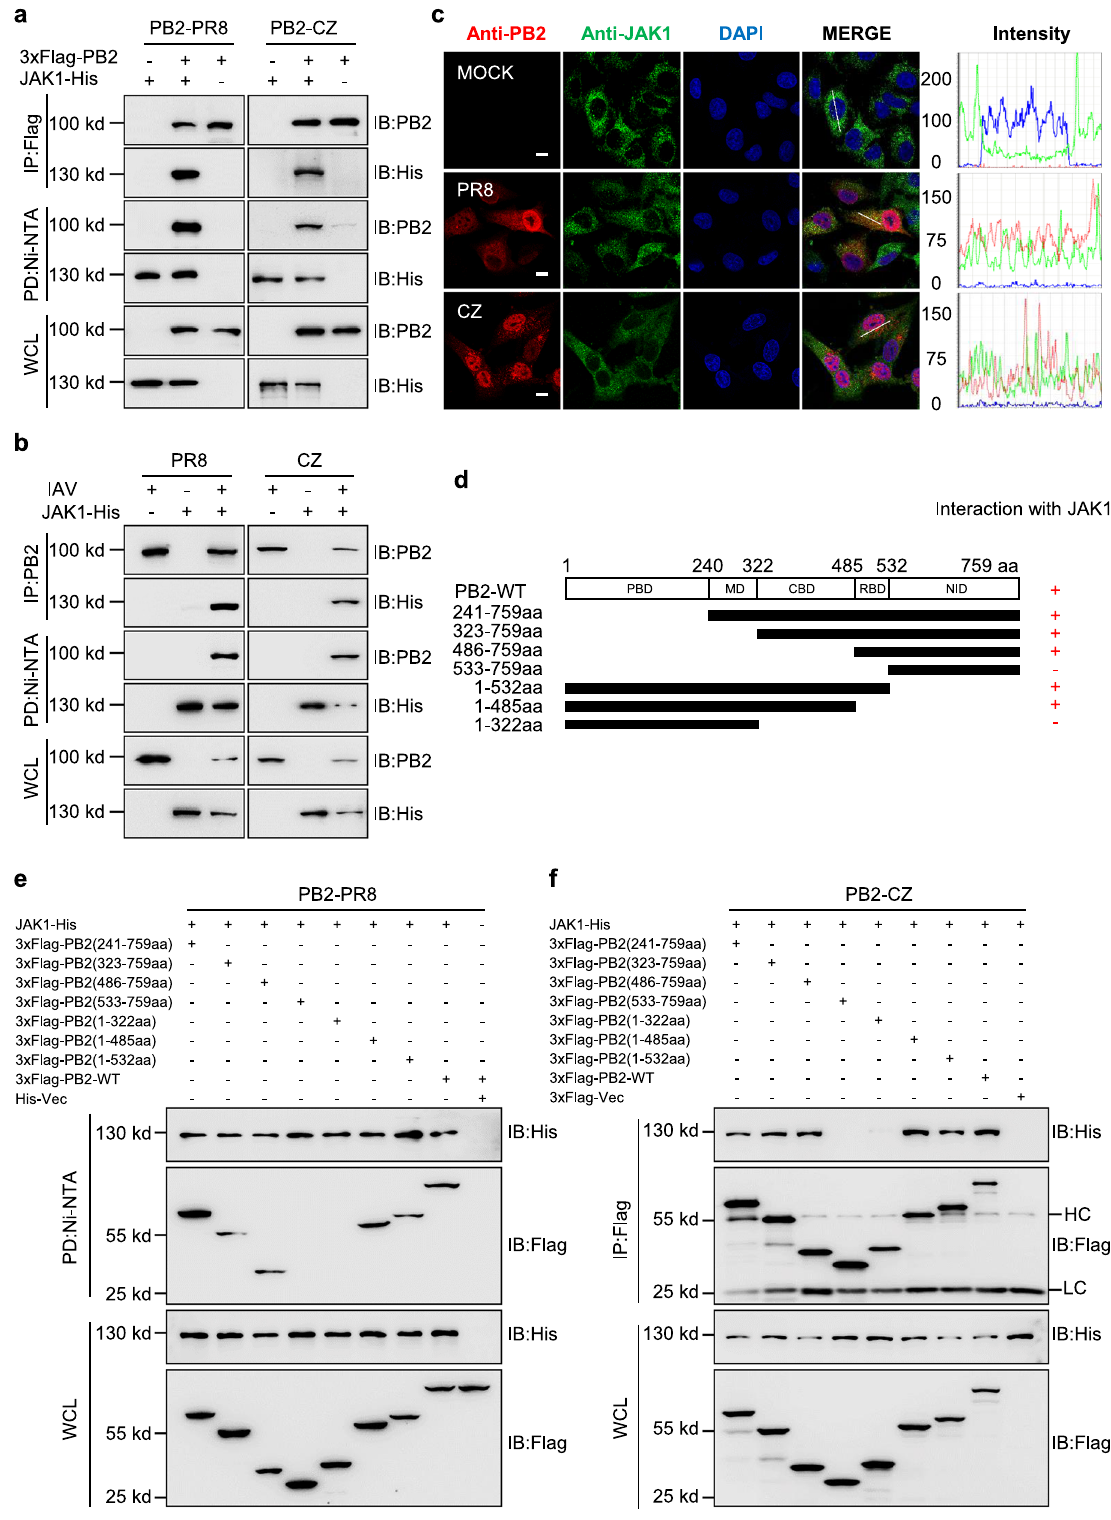
fl uorescence at indicated locations were scanned by LAS X Software. d Schematic representation of the deletion mutants of PB2. e , f Ni-NTA pull-down (e) and Co-ip analysis ( f ) of the interaction of JAK1 with PB2 and its truncation mutants in HEK293T cells. WCL whole-cell lysates, HC Heavy Chain, LC Light Chain. Data are one representative of three independent